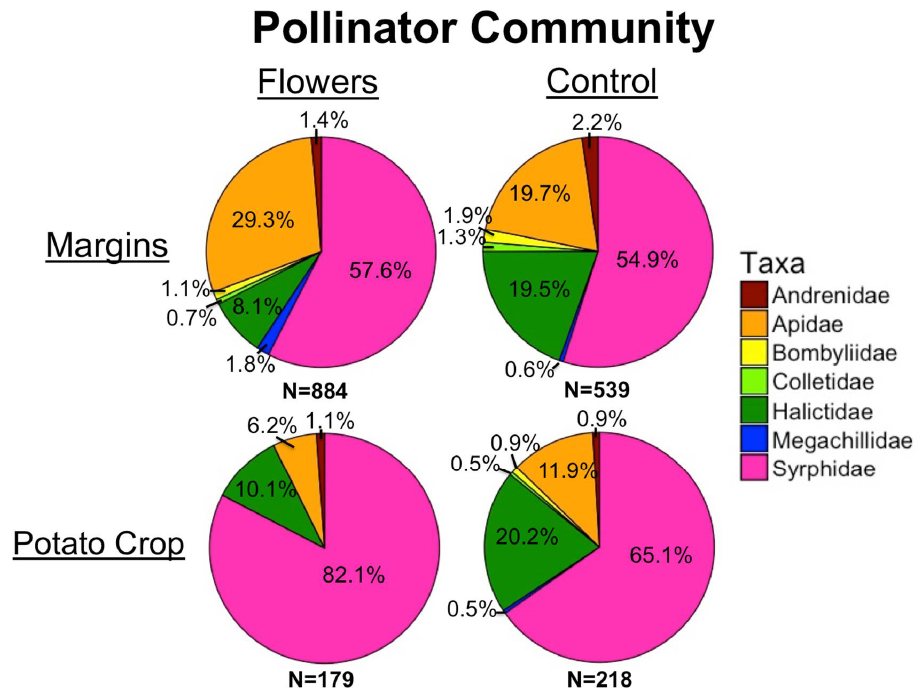
Figure 6. Pollinator community in margins and potato crops, with and without floral plantings. For predators, floral margins had little effect on abundance in potato fields, and almost no taxa measured within crops were significantly affected by this treatment. The one exception was Opiliones, possibly because some are highly mobile predators and spilled over from floral margins [67]. Our results suggest that few predators are moving from crop margins into adjacent fields, contrary to the findings of other studies [68]. Similar to pollinators, this may be due to a lack of resources within potato fields compared to field margins. Additionally, while a full analysis of predator communities is beyond the scope of this study, the predator communities within crops and within margins appeared very different from one another (Figure 7). These differences further suggest that predators are not simply spilling over from margins. Instead, our results indicate that different predator communities inhabit crop fields compared to margins, and that while some spillover likely occurs (as evidenced by higher abundances of predators in at the edge of the crop), the overall communities appear distinct.